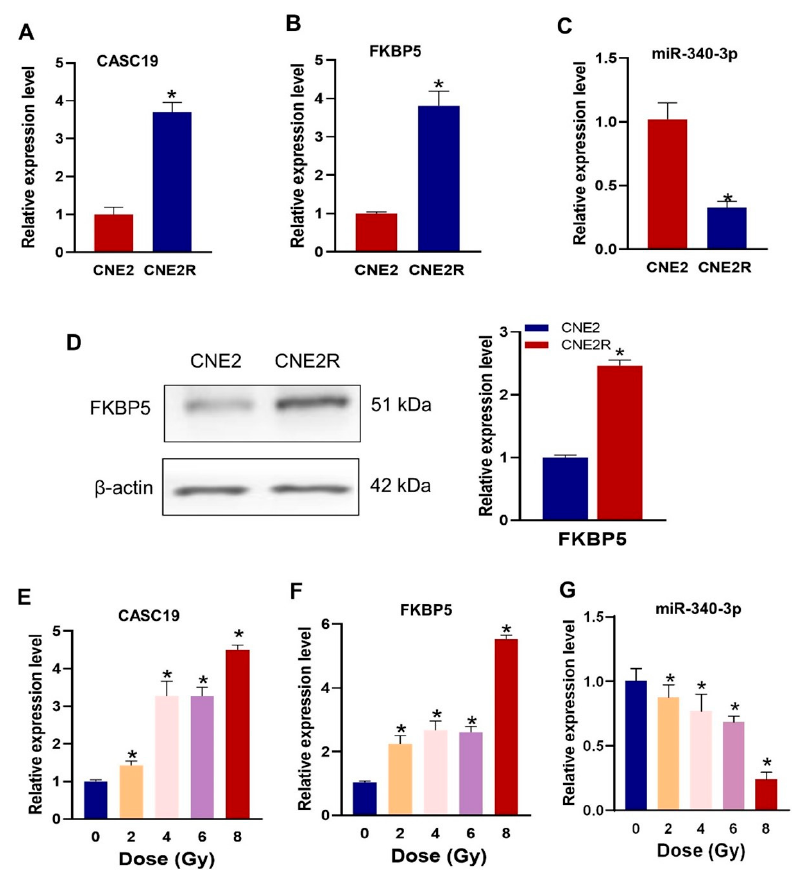
Figure 3. The expressions of CASC19, miR-340-3p, and FKBP5 in CNE2 and CNE2R cells: ( A – C ) the expressions of CACS19, FKBP5, and miR-340-3p detected using RT-PCR. * p < 0.05 compared with CNE2 cells; ( D ) the expression of FKBP5 protein detected with Western blot assay. * p < 0.05 compared with CNE2 cells; ( E – G ) the expressions of CASC19, FKBP5, and miR-340-3p in CNE2 cells irradiated with different doses. * p < 0.05 compared with nonirradiated control.